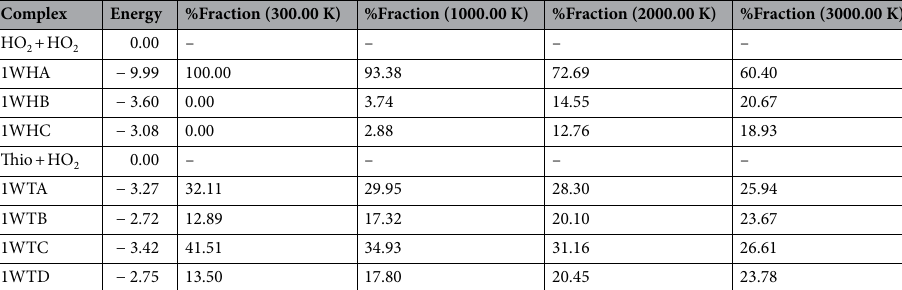
Table 1. The relative energy (kcal mol −1 ) and the percentage of fractions for the probable complexes formed between HO 2 and H 2 O, and thiophene and H 2 O computed at the BD(T)